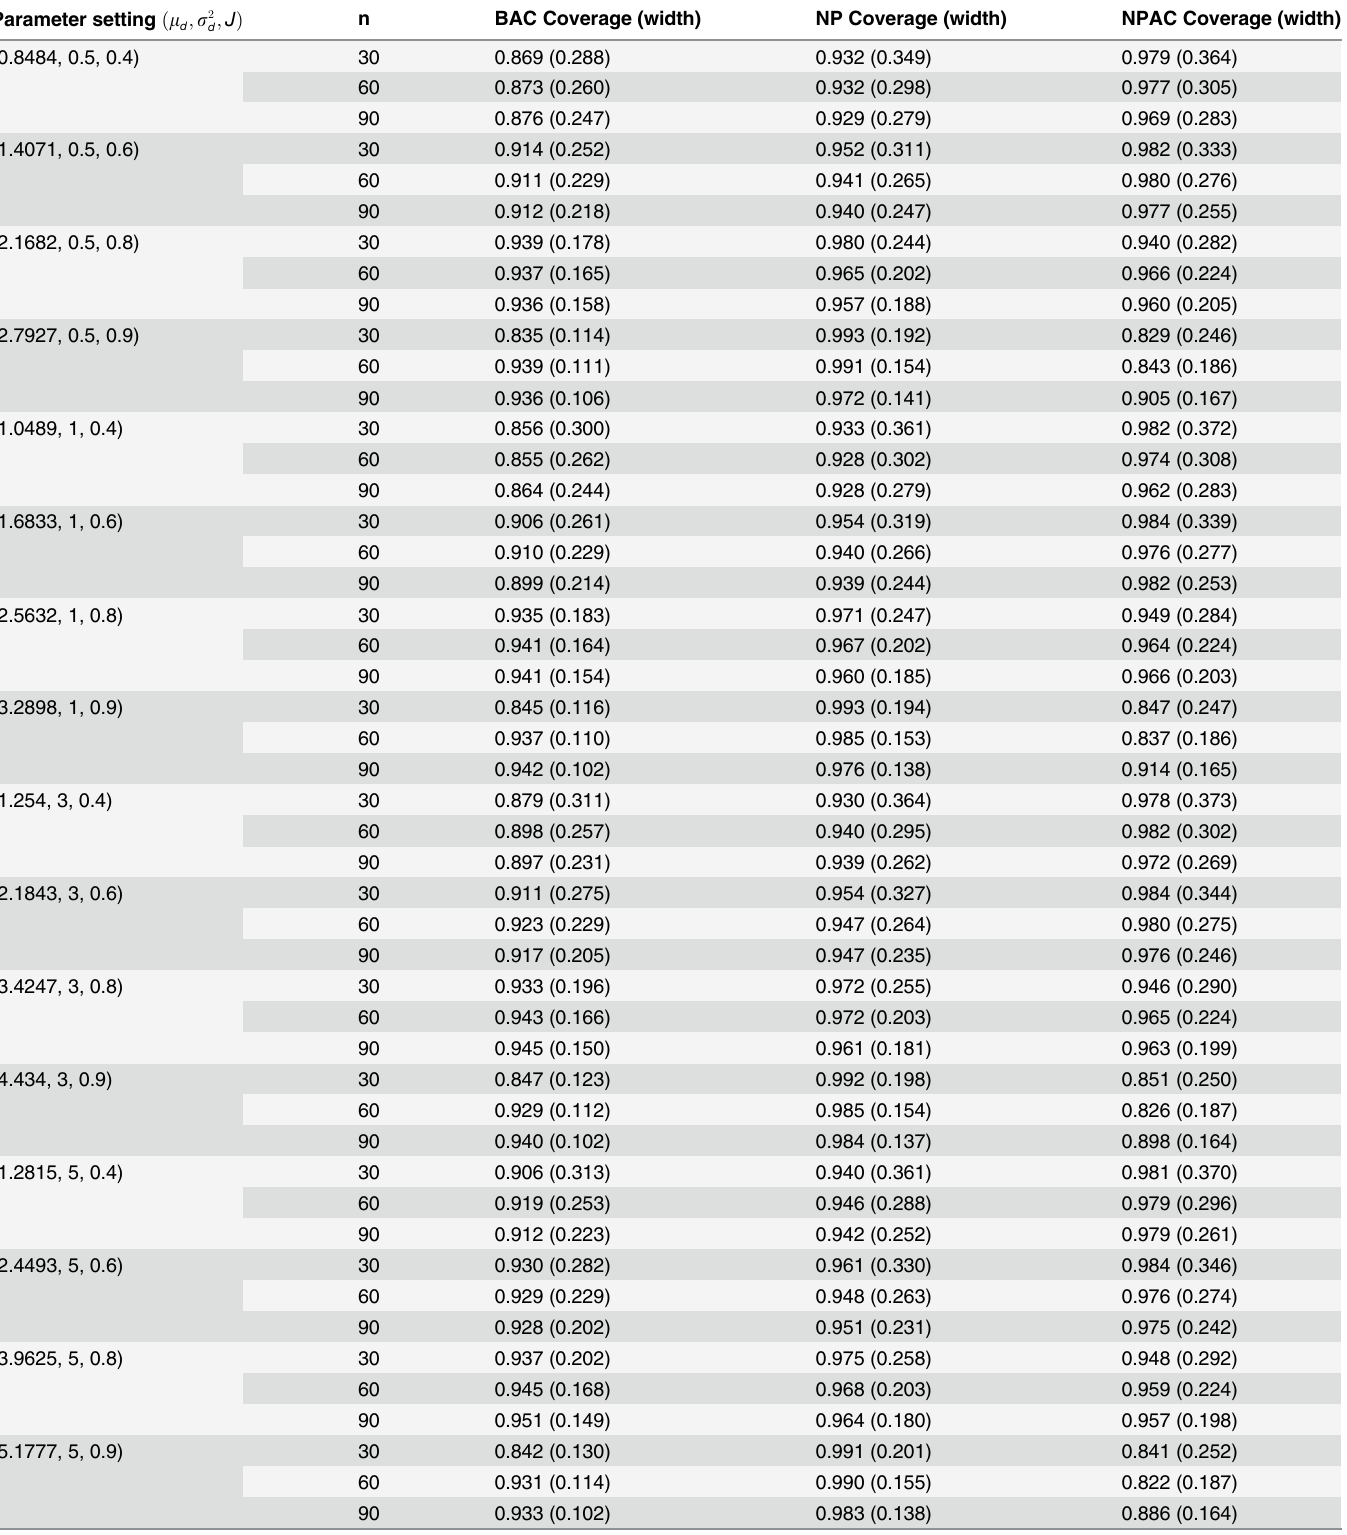
Table 3. Normal distributions: coverage probabilities and average widths when m = 60 in the non-diseased group at the 95% nominal